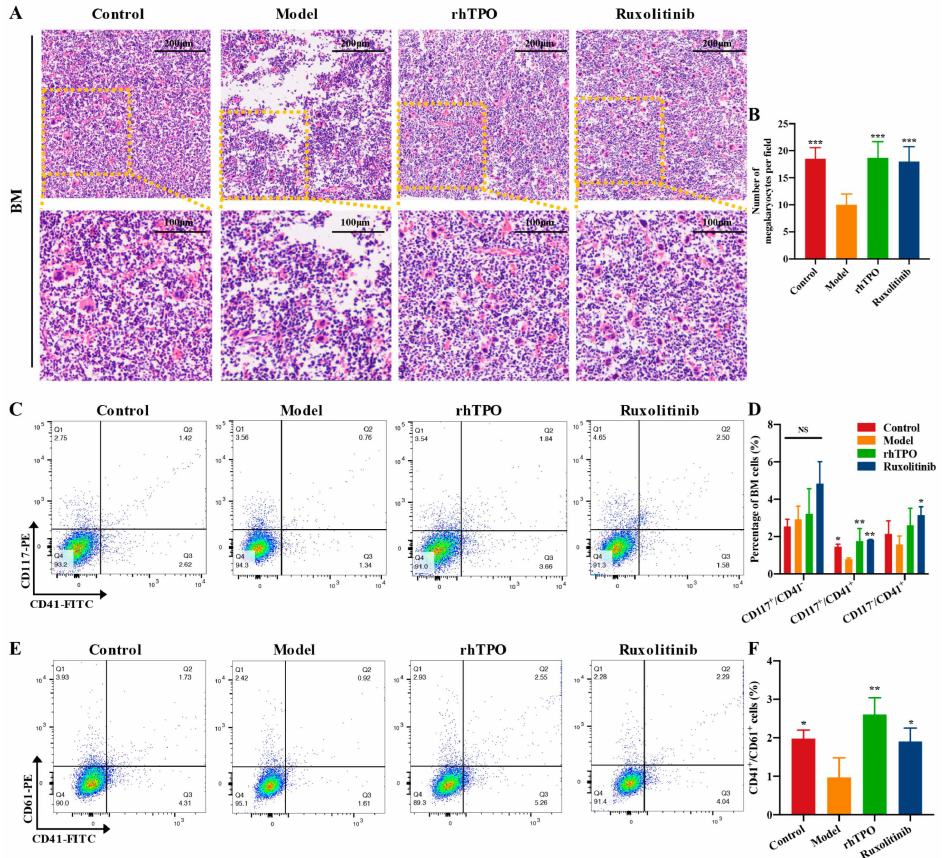
Figure 4. Ruxolitinib rescues bone marrow MKs post radiation injury. ( A ) Images of H&E staining of BM taken with a microscope at magnifications of 100 × (top) and 200 × (bottom); ( B ) The number of MKs in each group is indicated by the histogram. The data represent the mean standard devia‑ tion of three independent experiments; ( C ) The examination of the expression of c‑Kit and CD41 in each group by flow cytometry after receiving therapy for 12 days; ( D ) The histogram represents the − − percentage of c‑Kit + CD41 , c‑Kit + CD41 + , and c‑Kit CD41 + cells in each groups; ( E ) The examina‑ tion of the expression of CD41 and CD61 in each group by flow cytometry after receiving therapy for 12 days; ( F ) The histogram represents the percentage of CD41 + CD61 + cells in each group. Data represent the mean ± SD of three independent experiments. * p < 0.05, ** p < 0.01, *** p < 0.001 vs. the model